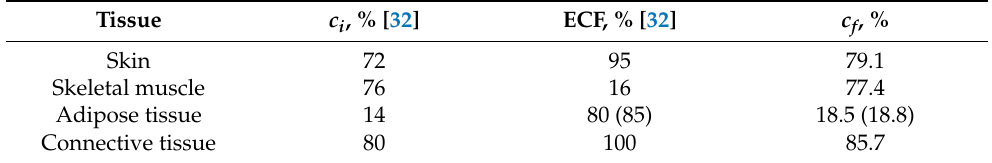
Table 1. Initial and expected water content for a 50% increase in IFV for different tissue